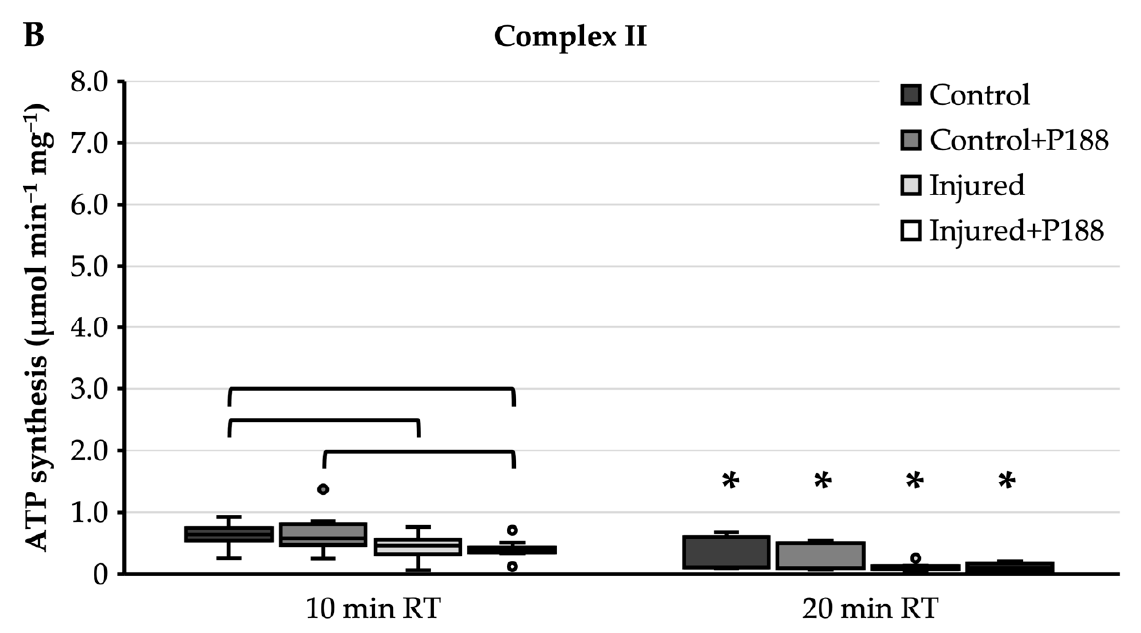
Figure A4. Comparison of adenosine triphosphate (ATP) synthesis ( µ mol · min − 1 · mg − 1 ) between differently treated hydrogen peroxide (H 2 O 2 )-injured, isolated mitochondria for complex I ( A ) and II ( B ) substrates in control, control + Poloxamer (P)188, injured, and injured + P188 mitochondria. Condition is defined by total time of exposure of isolated mitochondria to room temperature (RT). Boxplots show 25th, 50th, and 75th percentile; whiskers represent minimum and maximum. Statistical significance ( p < 0.05) within one condition was denoted by brackets; statistical significance ( p < 0.05) between the same groups of different conditions was denoted by *; complex I: 10 min RT: n = 7, 20 min RT: n = 5; complex II: 10 min RT: n = 7, 20 min RT n = 5.